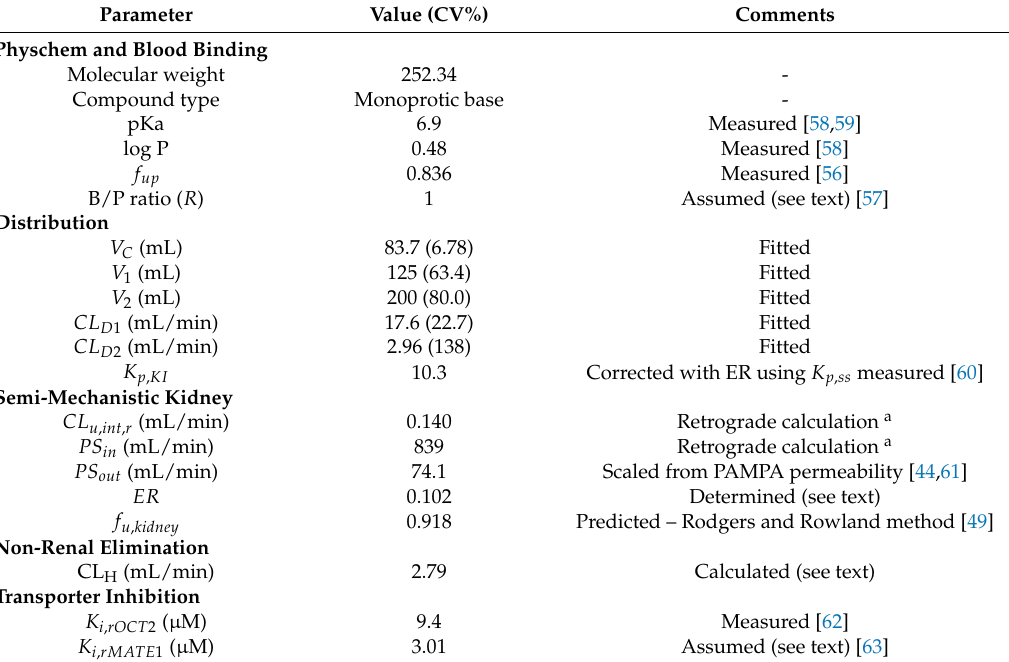
Table 3. Input parameters for PBPK modeling of